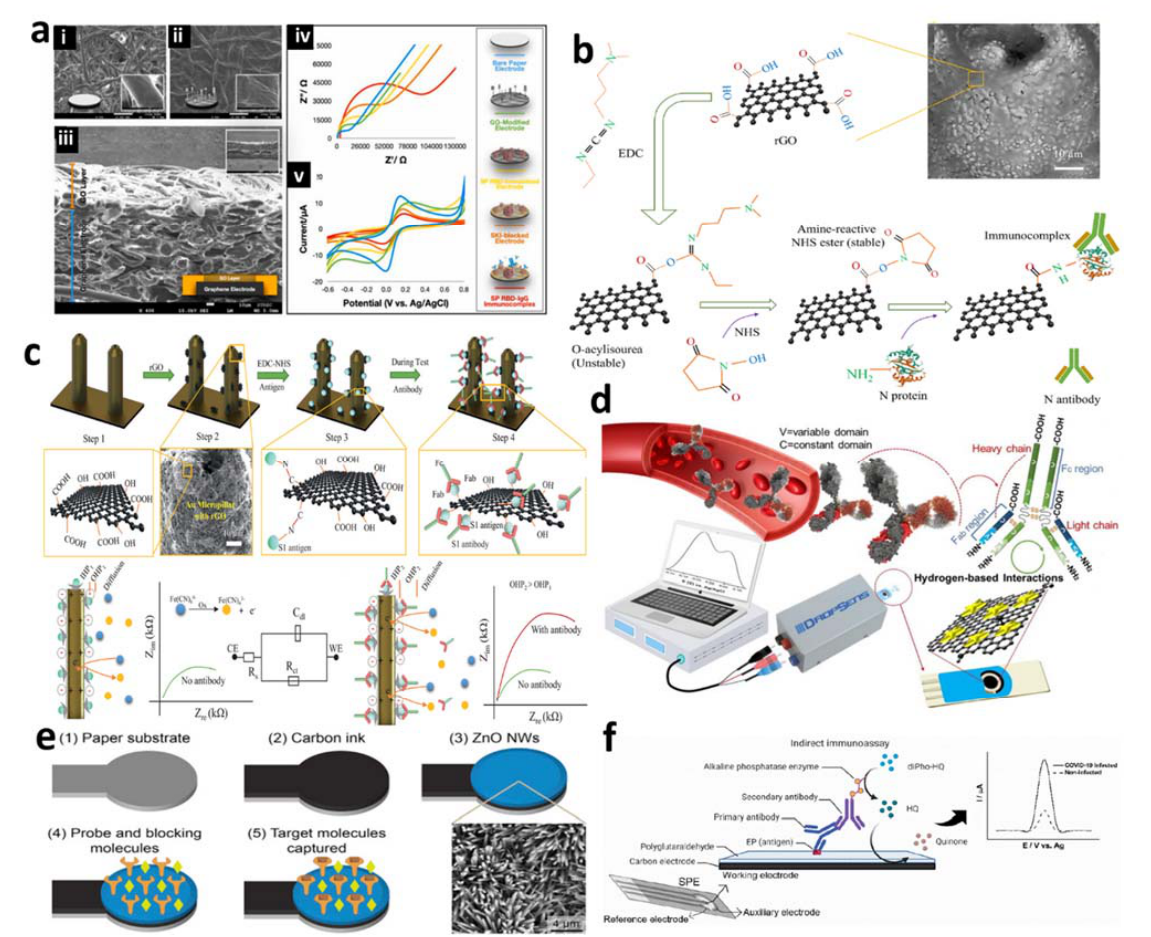
Figure 3. ( a ) Surface morphological FE-SEM images of the (i) bare paper and (ii) graphene oxide (GO)-modified paper with a cross-sectional image of (iii) GO/paper, corresponding to the (iv) CV and (v) EIS responses with the schematic of each modification steps for the detection of IgG antibodies (adapted with permission from ref. [54]). Copyright 2021 Elsevier. ( b ) Schematic of stepwise fabrica- tion of reduced GO (rGO)-Au micropillars for IgG antibody detection (reprinted with permission from ref. [55]). Copyright 2022 Wiley. ( c ) Functionalization of nano-printed rGO-coated 3D Elec- trodes for the binding of IgG antibodies against spike protein of SARS-CoV-2, sensing principle, and interfacial properties of electrode/electrolyte interface with corresponding EIS spectrum (reprinted with permission from ref. [56]). Copyright 2021 Wiley. ( d ) Schematic illustration of the interaction (adapted with permission from ref. [57]). Copyright 2021 Elsevier. ( e ) Schematic of the fabrication permission from ref. [58]). Copyright 2021 Elsevier. ( f ) Schematic representation of the